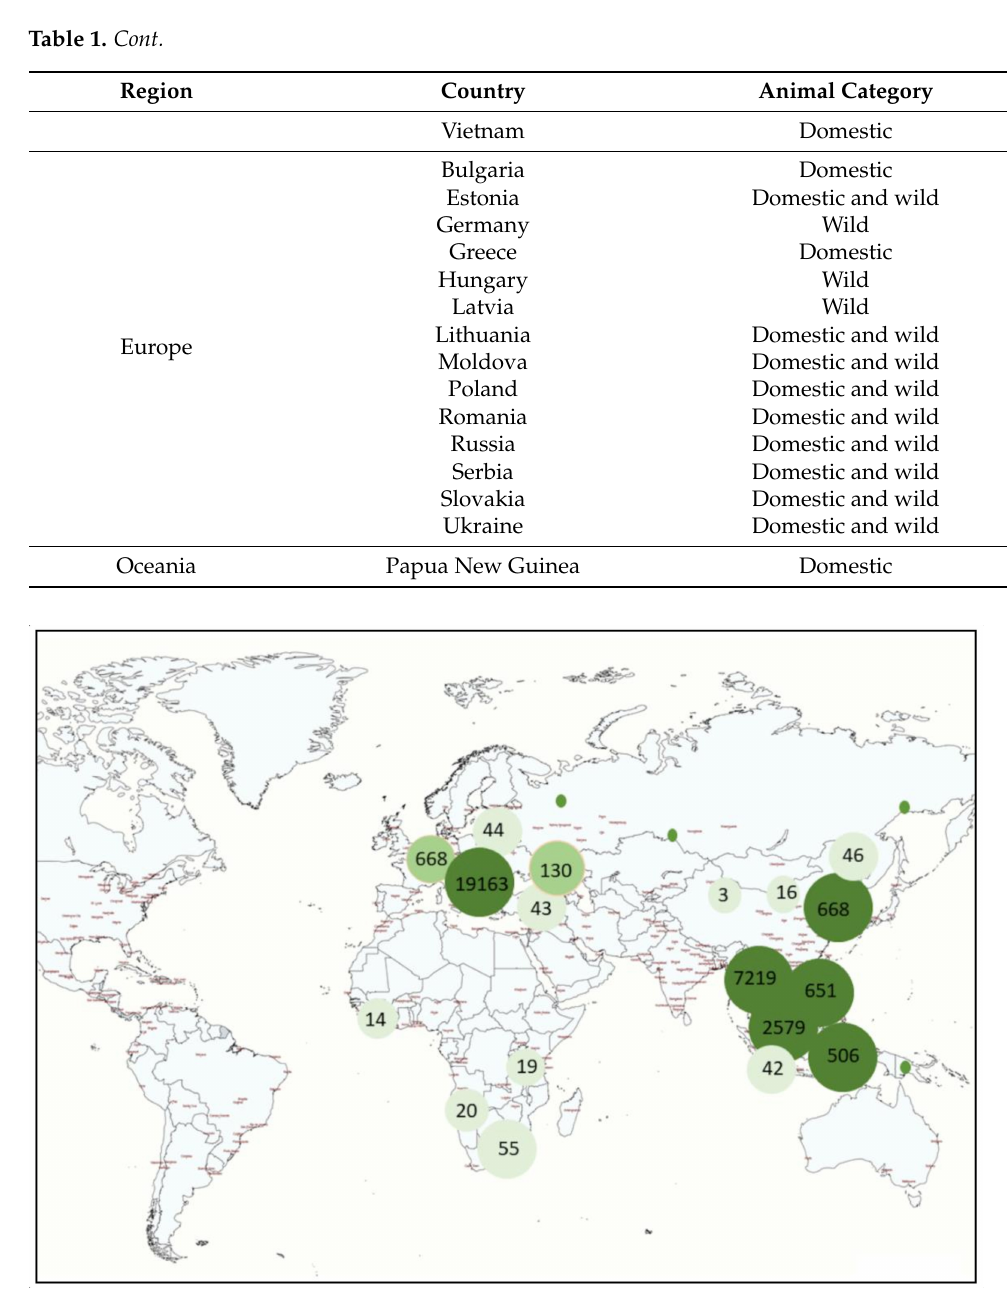
Figure 1. The number of ASF outbreaks around the world from January 2020 to March 2021